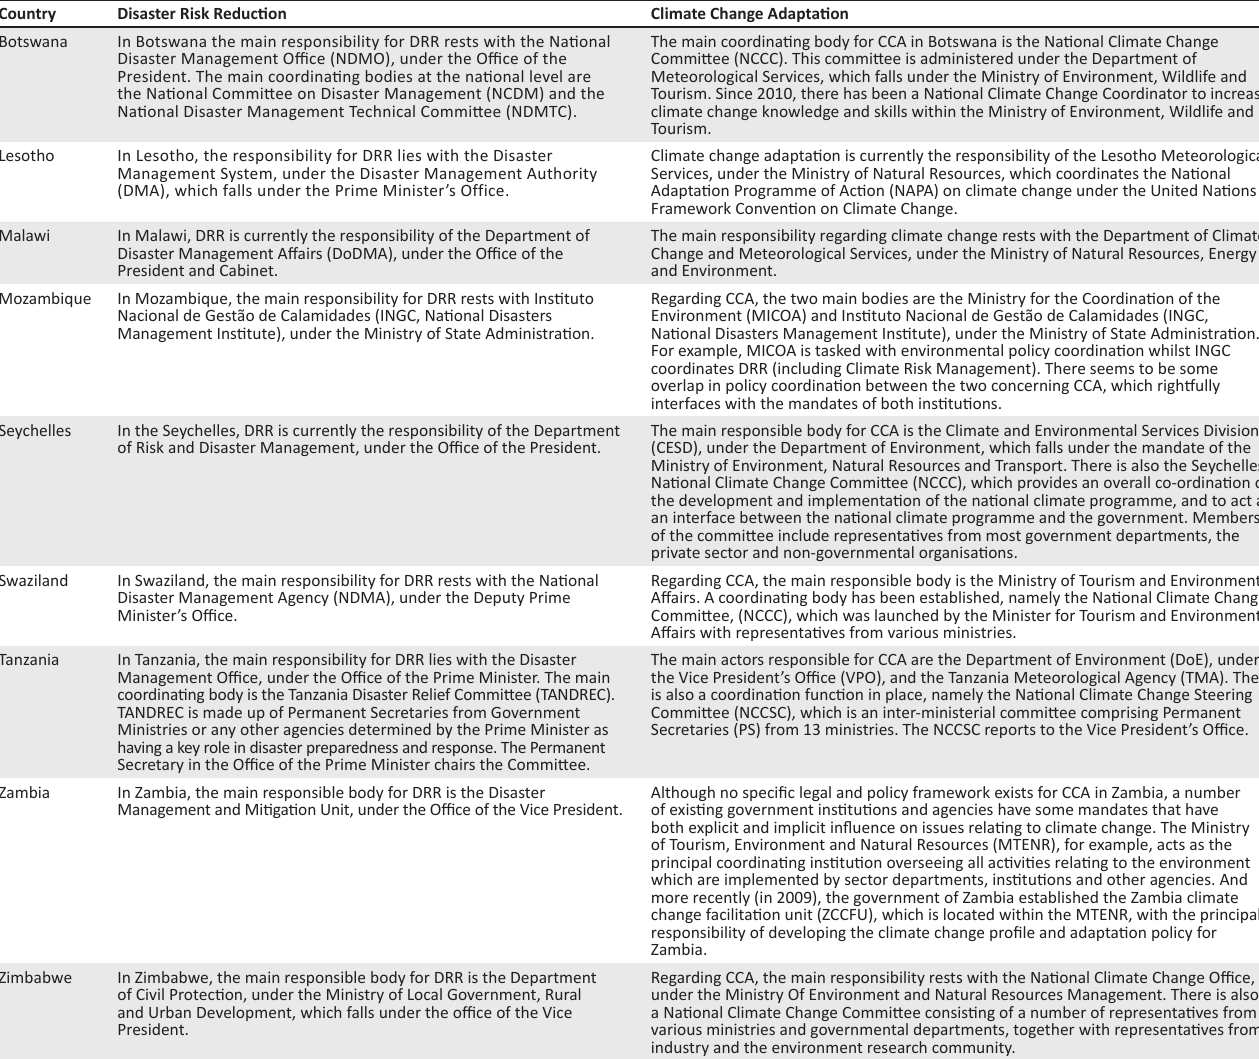
TABLE 1: Brief descriptions of institutional setups for disaster risk reduction (DRR) and climate change adaptation (CCA) in the selected